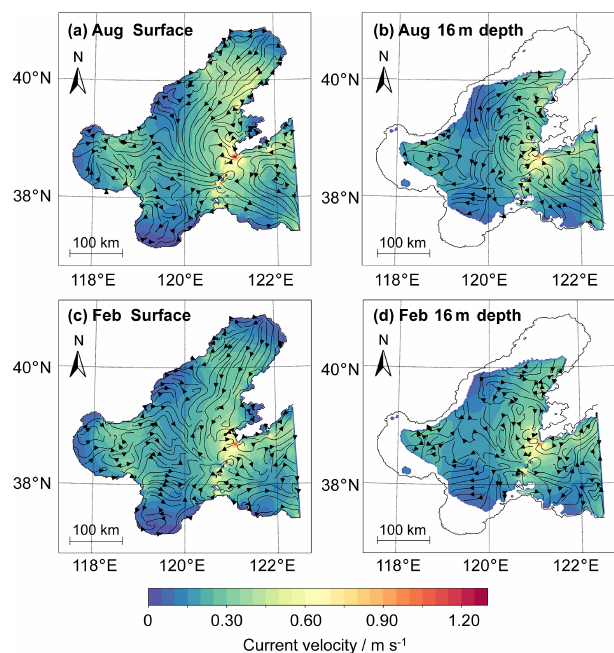
Figure 5. Simulated monthly mean current velocities at the surface and 16m depth in August 2012 and February 2013. The monthly mean current velocities are calculated based on the outputs with hourly intervals. The black lines and arrows represent the stream- lines and directions of the current vector field, respectively. The filled contours denote the current speed (in ms − 1